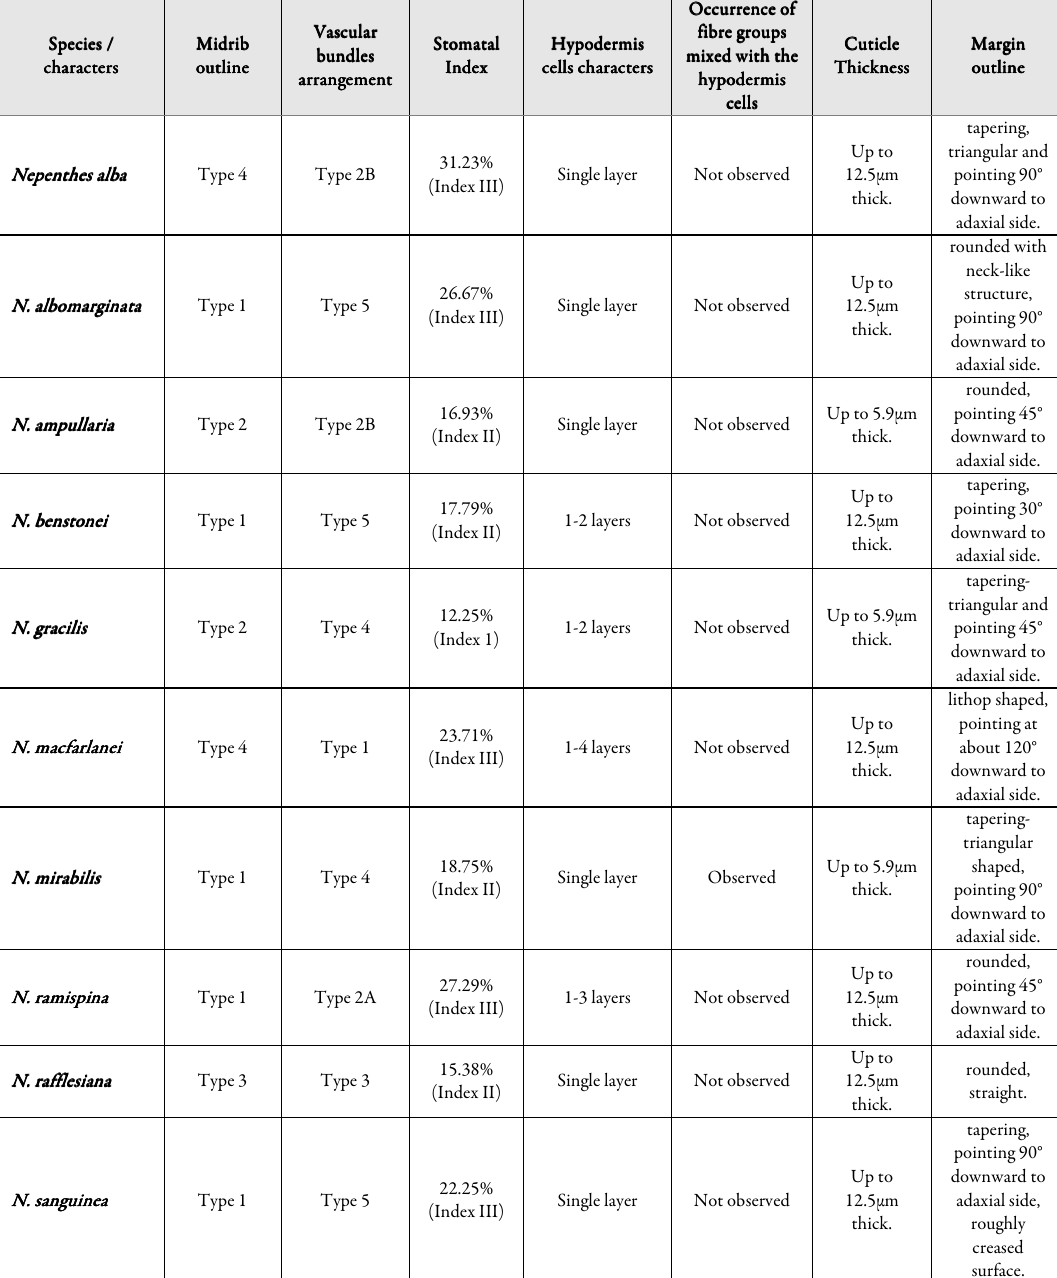
Table 3. Comparison anatomical characterisation of studied Nepenthes specimens Species /